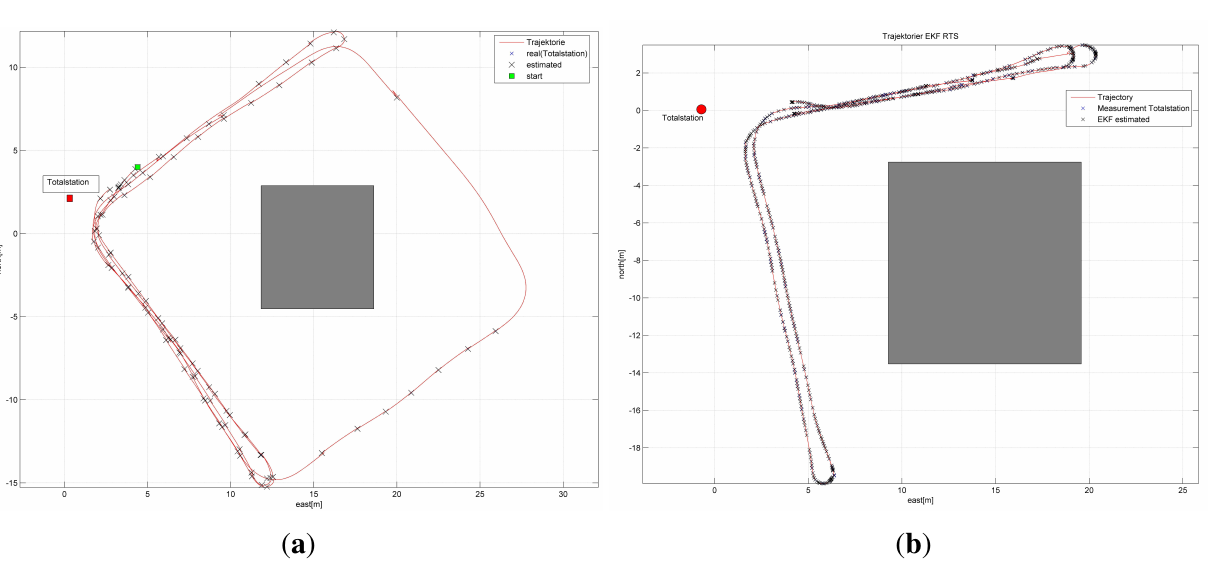
Figure 8. The two measured indoor trajectories. On the left, a round-trip through the HCUbuilding, with the total station’s line of sight interrupted by a visual obstruction. The right image shows a trip without any interruption of the total station observation.